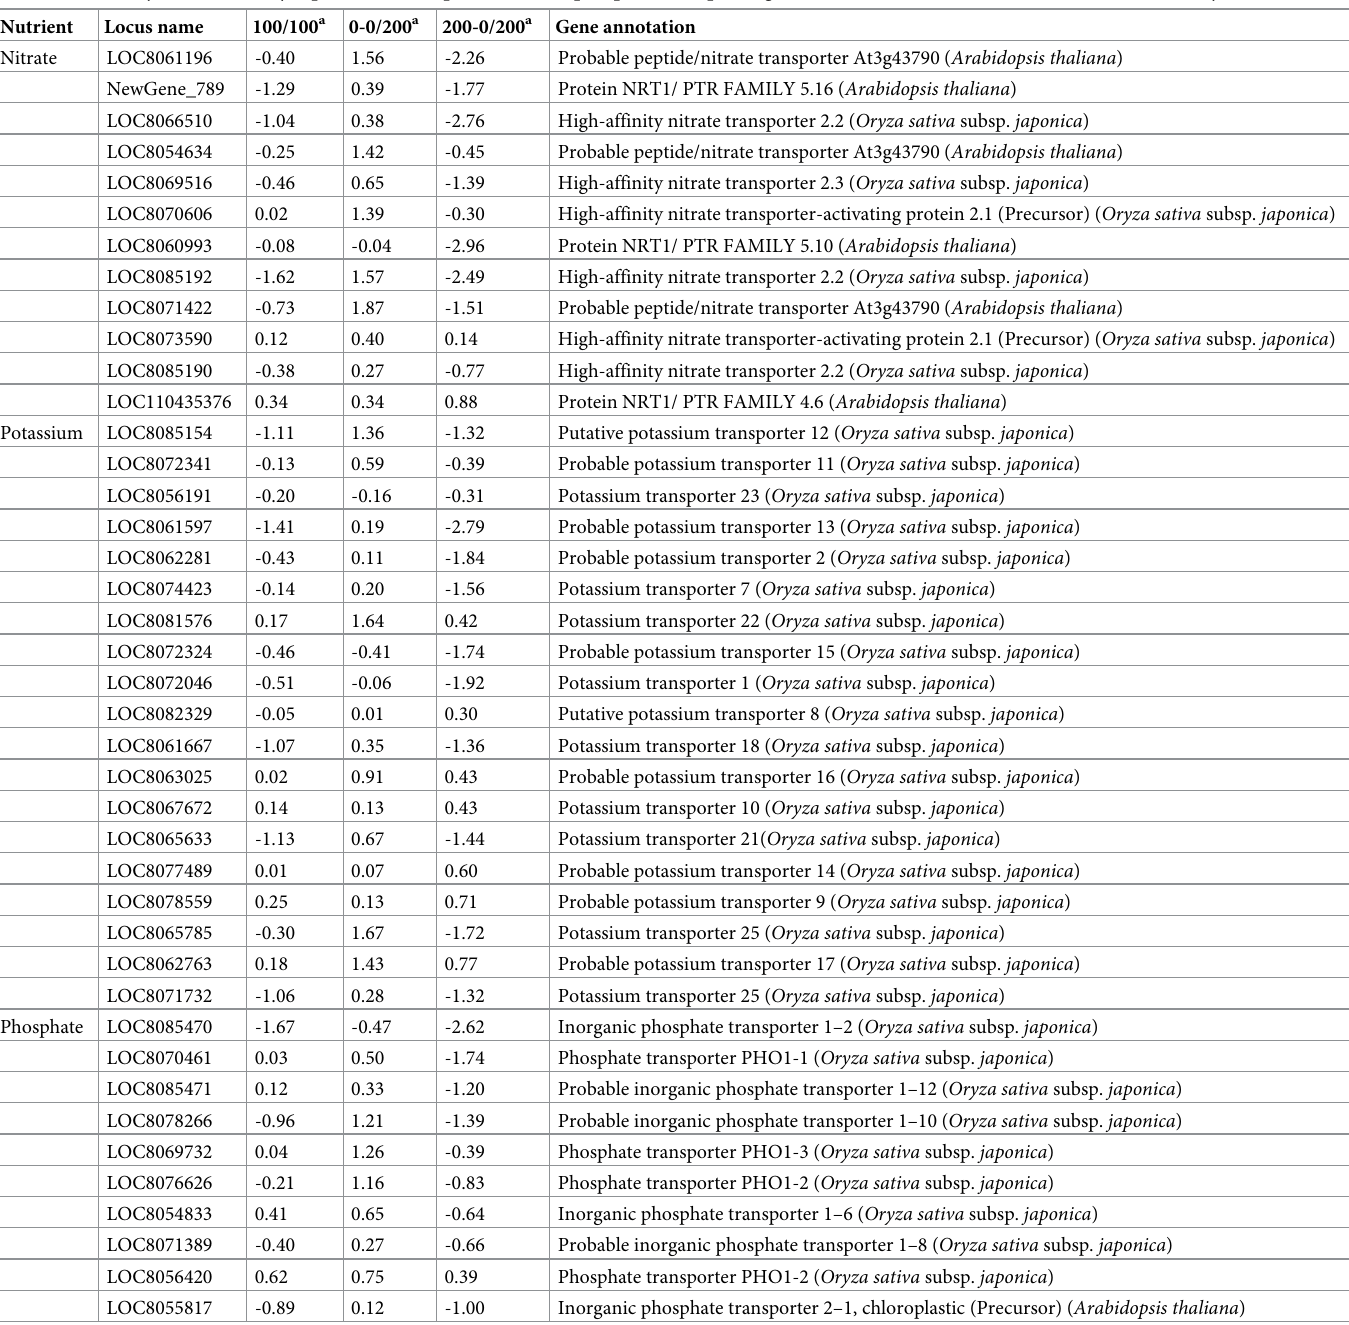
Table 4. Summary of differentially expressed nitrate, potassium, and phosphate transporter genes in roots under uniform and non-uniform salinity treatments. Nutrient Locus name